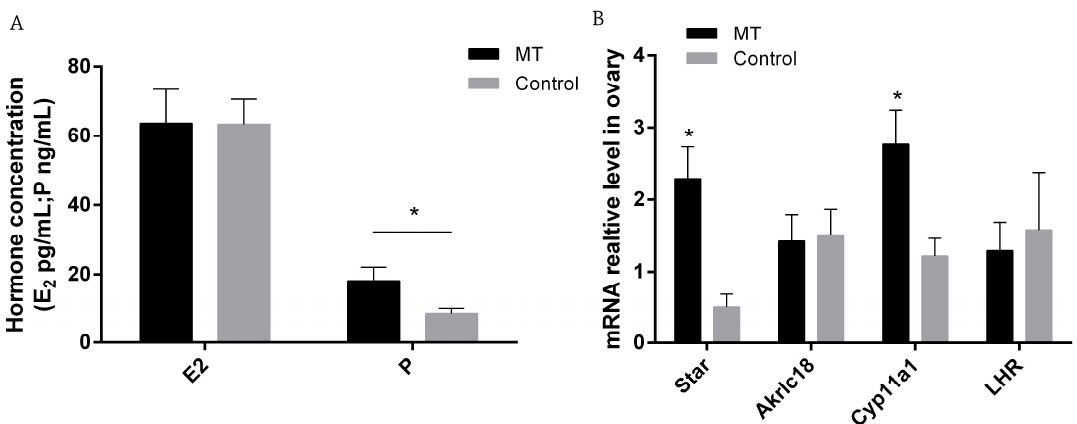
Figure 2. Effects of melatonin on estradiol (E 2 ) and progesterone (P) levels as well as the mRNA of StAR , Akrlc18 , Cyp11a1 , and LHR in D0.5 gestation mice. ( A ) Serum E 2 and P concentrations ( n = 10); ( B ) The relative levels of mRNAs of StAR , Akrlc18 , Cyp11a1 , and LHR in mice ovaries ( n = 7), detected by Q-PCR. The RT-QPCR was independently repeated three times. “*” represents a significant difference of these columns ( p < 0.05).